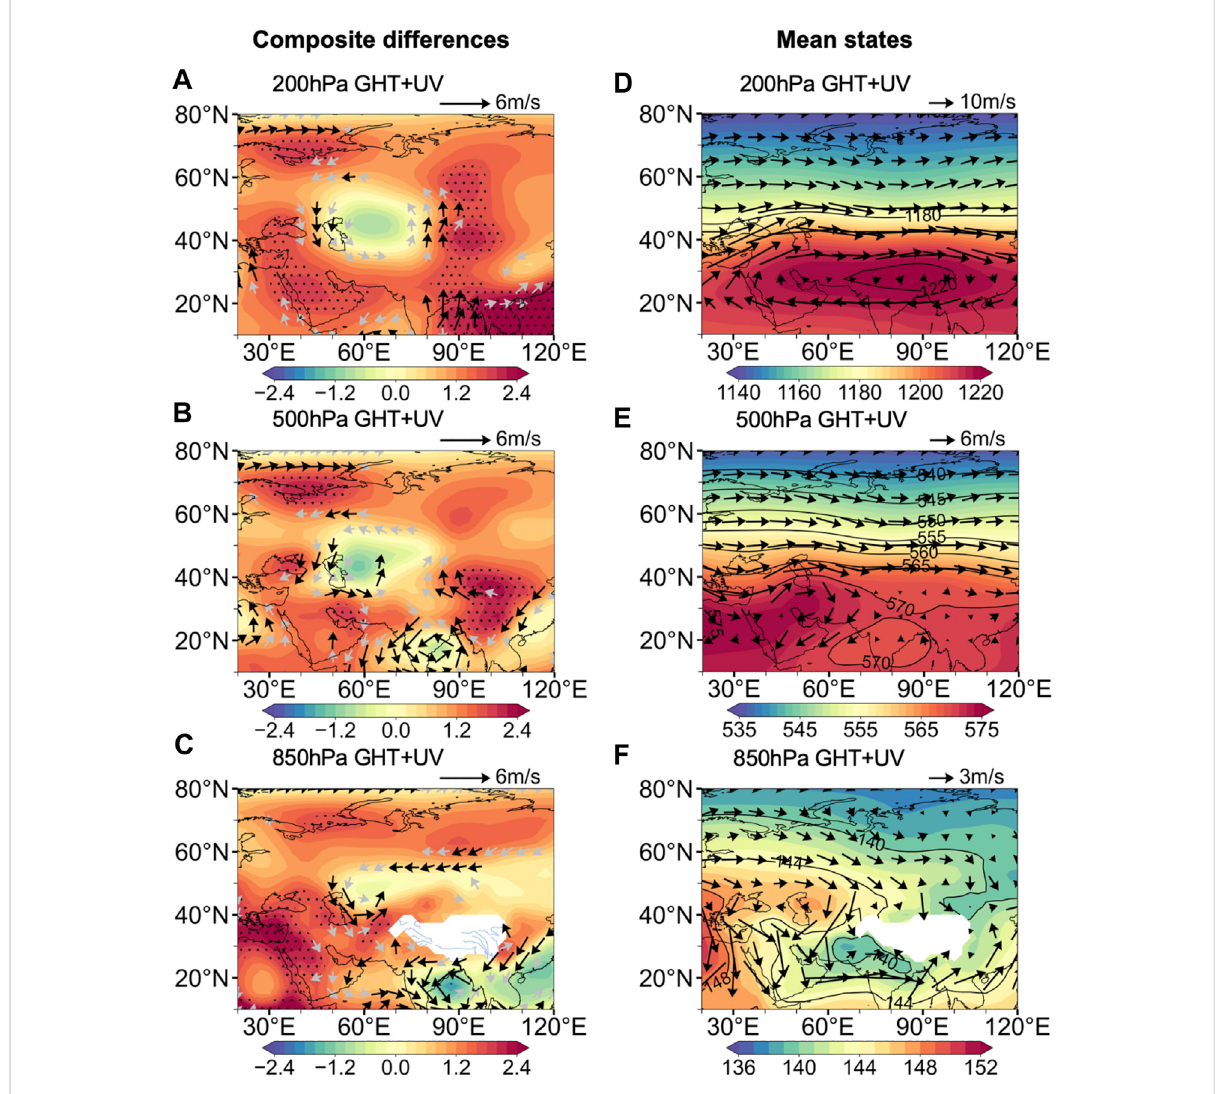
FIGURE 6 (A – C) Compositedifferences(HSminusLS)ofwindandgeopotentialheight(GHT,color)at850 hPa,500 hPa,and200 hPaduring1901 – 2010. Black dots marks regions where GHT differences are above 90% con fi dence level. The black vectors show the wind differences are over 90% con fi dencelevel (D – F) Backgroundclimatology statesGHTandwindsat850 hPa,500 hPa,and850 hPainsummeroverEurasiaduring1901 – 2010. The wind and geopotential data at 850 hPa on the Qinghai-Tibet Plateau are